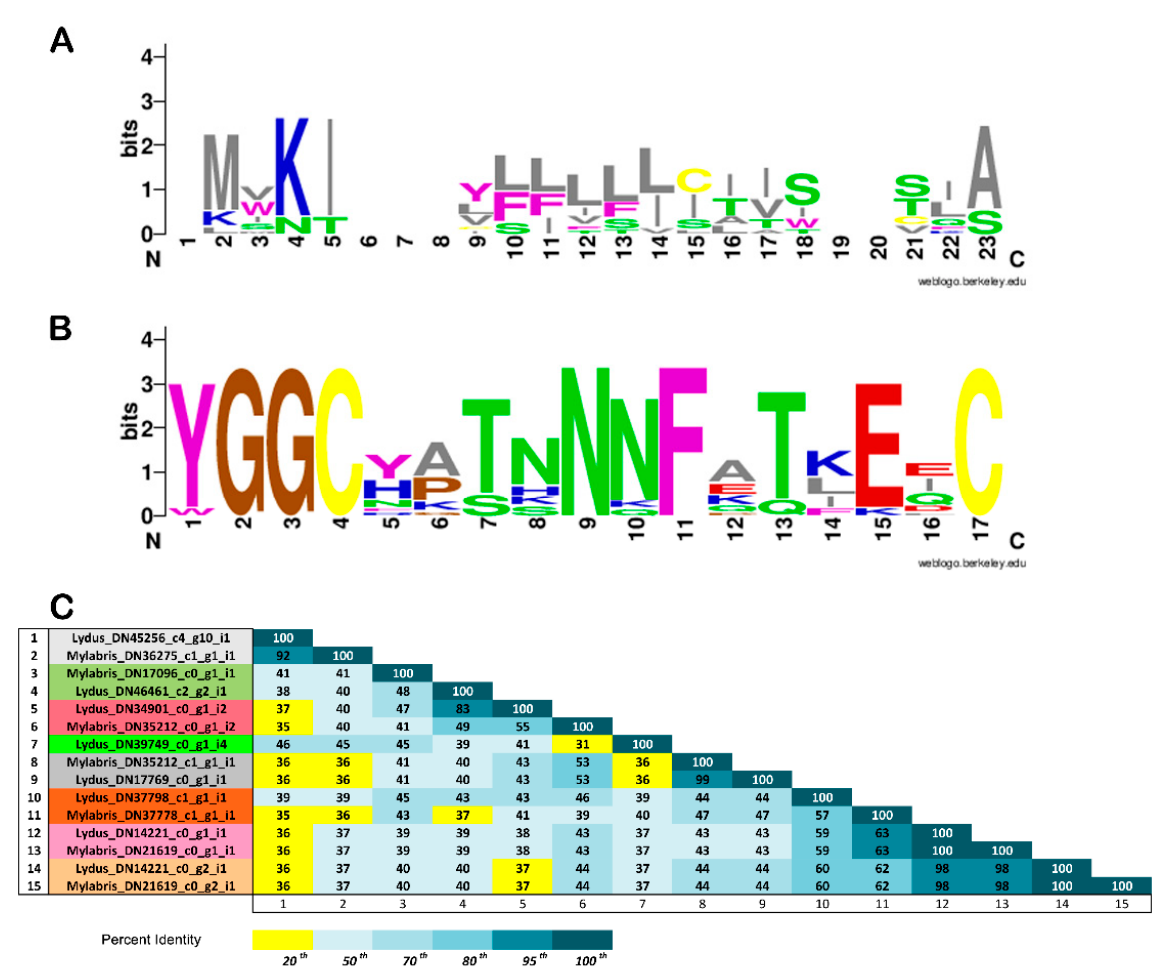
Figure 6. Analyses of the identified translational KTPI products from Lydus trimaculatus and Mylabris variabilis . ( A ) Leader peptide consensus sequence using the program WEBLOGO. ( B ) Kunitz family signature sequence (amino acids’ colour code: blue, polar positive; red, polar negative; green, polar neutral; grey, nonpolar aliphatic; purple, nonpolar aromatic; brown, proline, glycine; yellow, cysteine. ( C ) Pairwise sequence similarity with percent identity highlighted as percentile. Orthologous sequences from L. trimaculatus and M. variabilis are highlighted with the same colour of the left-hand column.